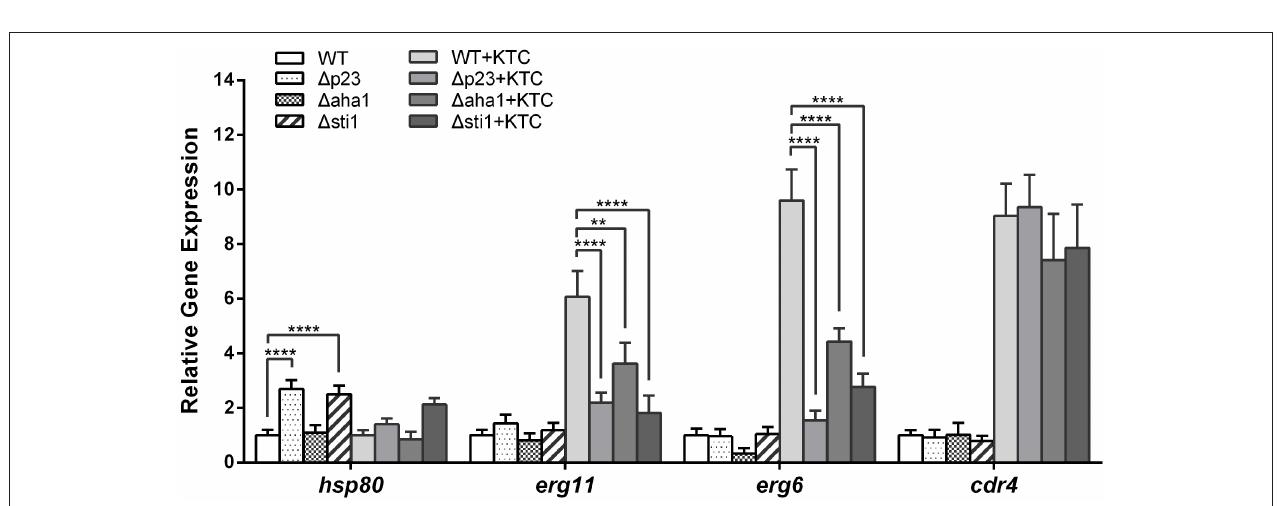
FIGURE 4 | Differential expressions of genes in the ∆ sti1 , ∆ aha1 , and ∆ p23 strains relative to the wild type (WT) strain was determined by quantitative RT-PCR. Strains were grown in liquid Vogel’s medium at 28 ◦ C with shaking at 180 rpm for 12h. Then ketoconazole (KTC) was added to the medium to reach 2.5mg/L. After 24h incubation, the following genes were analyzed by quantitative RT-PCR: hsp80 , erg11 , erg6 , and cdr4 . Values shown are the means of three independent replicates. Standard deviations are indicated by error bars, and differences between the mutants and WT were statistically analyzed by analysis of variance. Values with P < 0.0001, 0.0001 < P < 0.001, 0.001 < P < 0.01, and 0.01 < P < 0.05 are marked with ****, ***, ** and *,